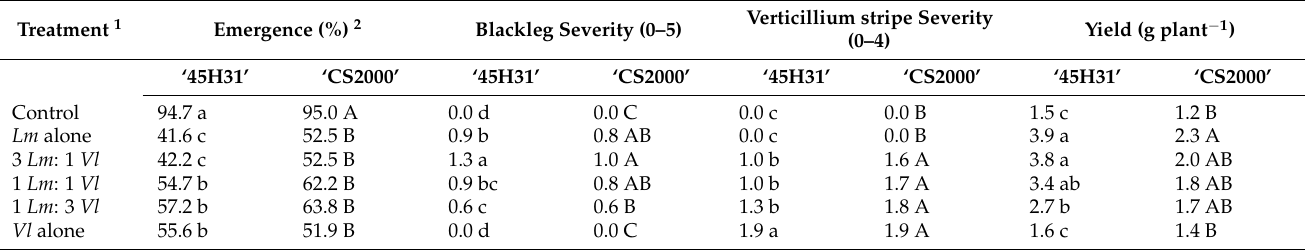
Table 4. Seedling emergence, blackleg severity, Verticillium stripe severity and seed yield of the canola hybrids ‘45H31’ and ‘CS2000’ following inoculation with Leptosphaeria maculans ( Lm ) and/or Verticillium longisporum ( Vl ) alone and in various combinations under greenhouse